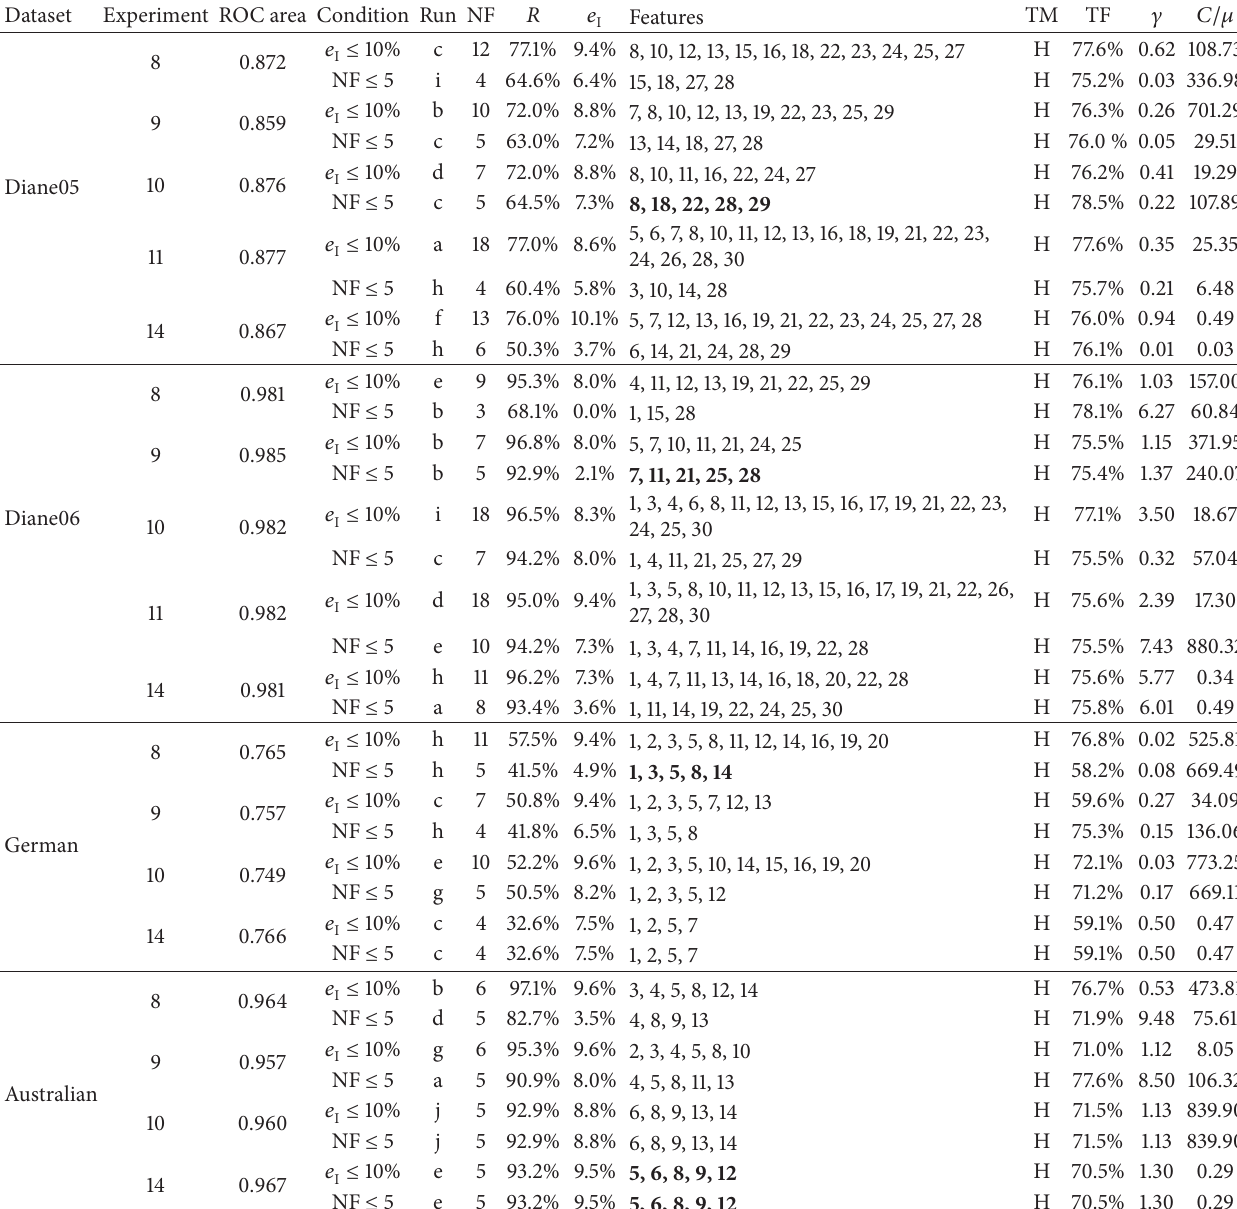
Table 7: Results summary for Experiments 8, 9, 10, 11, and 14 and for all databases.